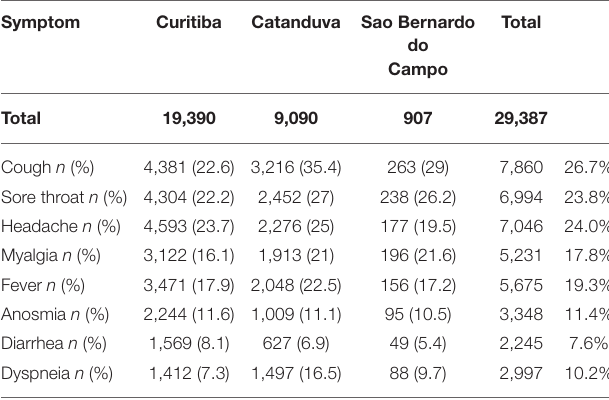
TABLE 2 | Distribution of the most reported symptoms.